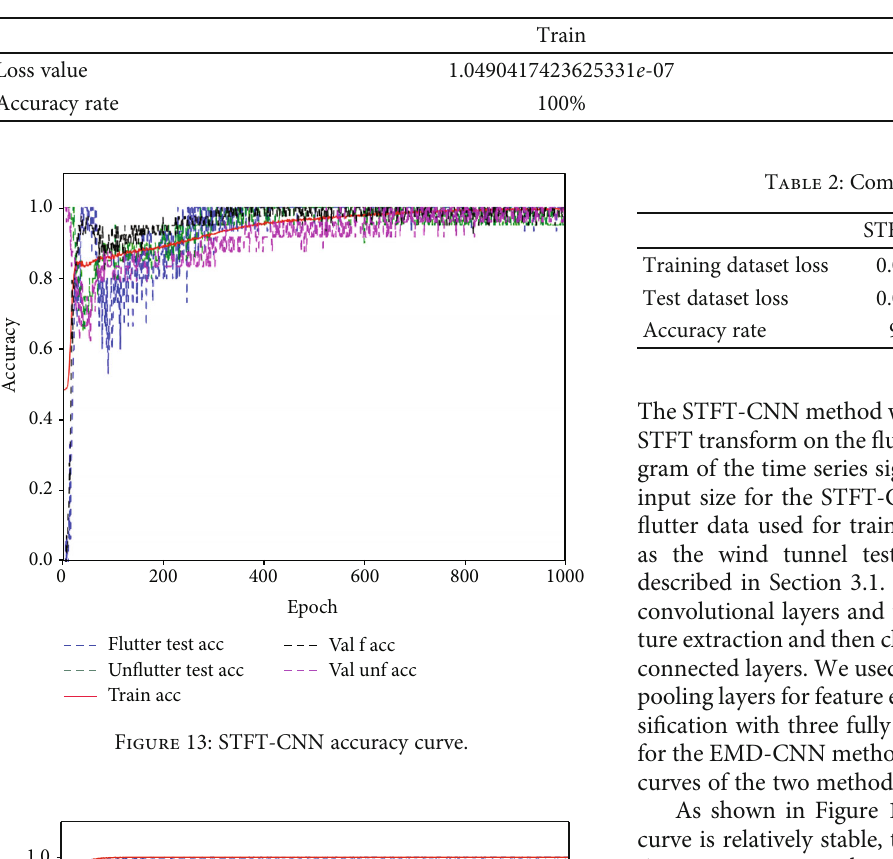
Table 1: Model validation results.